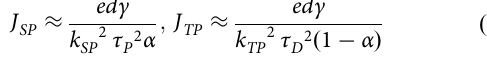
(cid:1) (cid:3) = S (cid:2) S , where S represents ST TP 0 ST